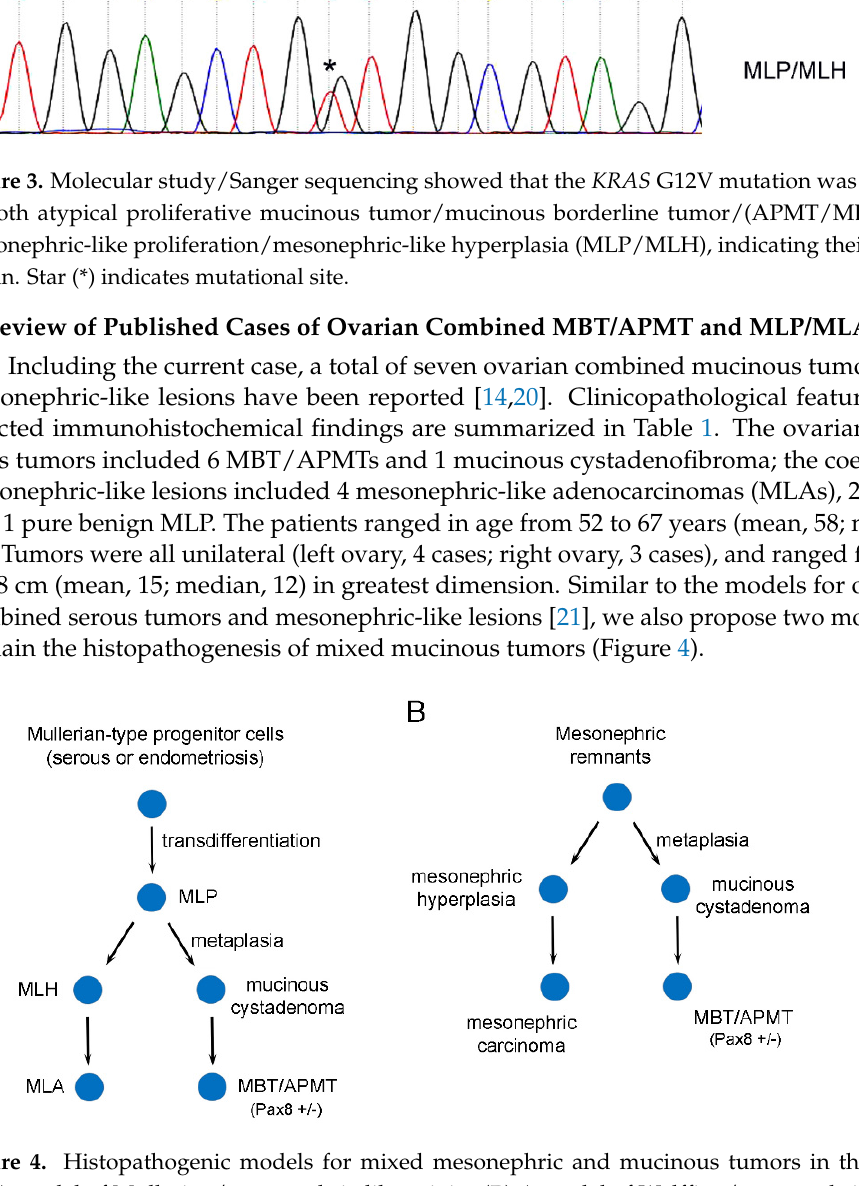
Table 1. Clinicopathological features and selected immunohistochemical findings.